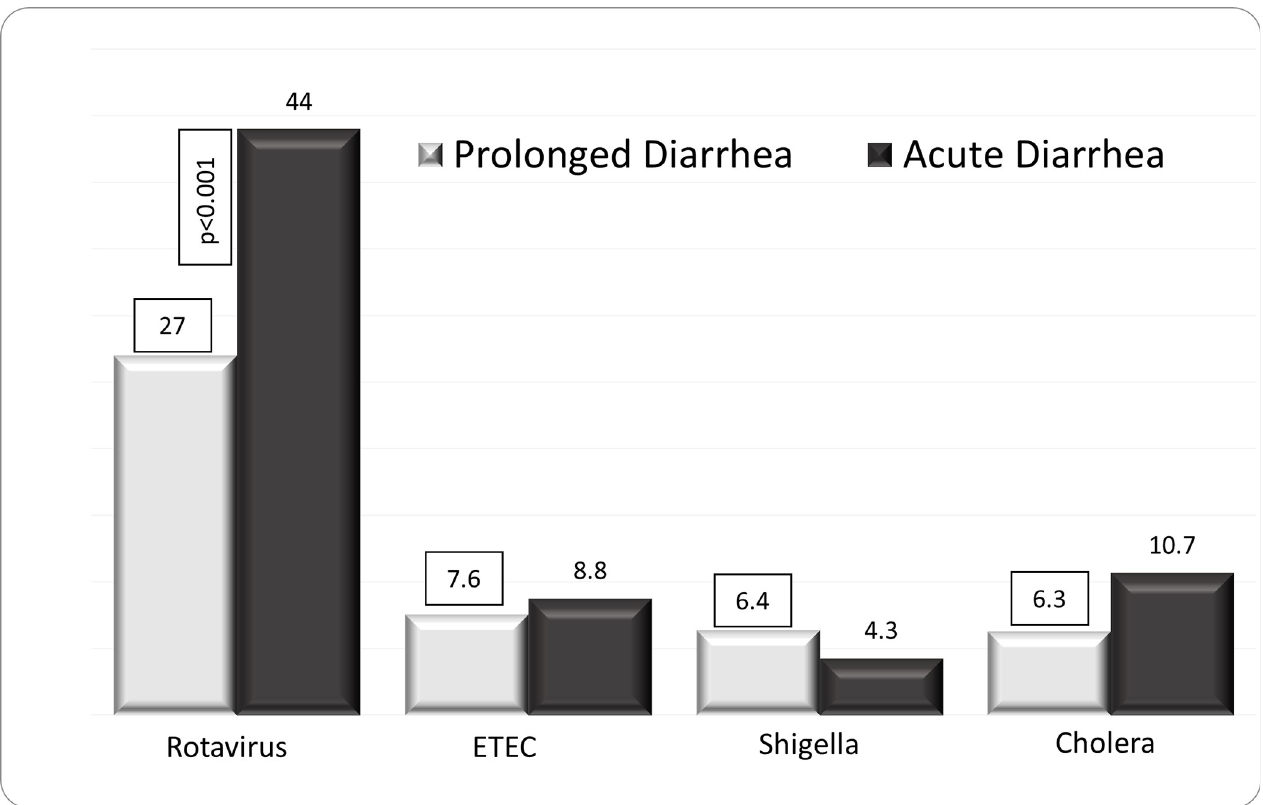
Fig 1. Percent of children with different stool organisms by prolonged diarrhea and acute diarrhea.